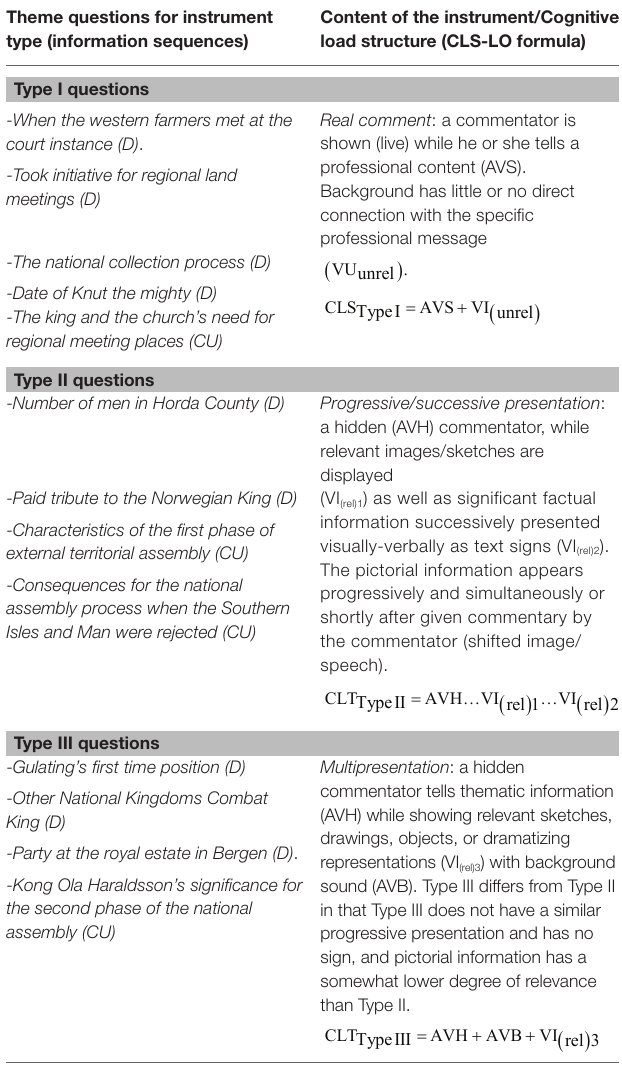
Content of the instrument/Cognitive load structure (CLS-LO formula)